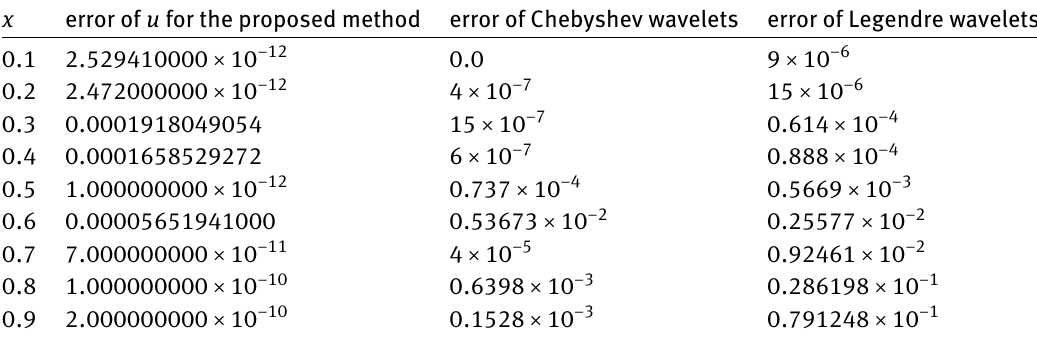
Table 1: Comparison of the error for proposed method, Chebyshev, and Legendre wavelets method for Example 1.